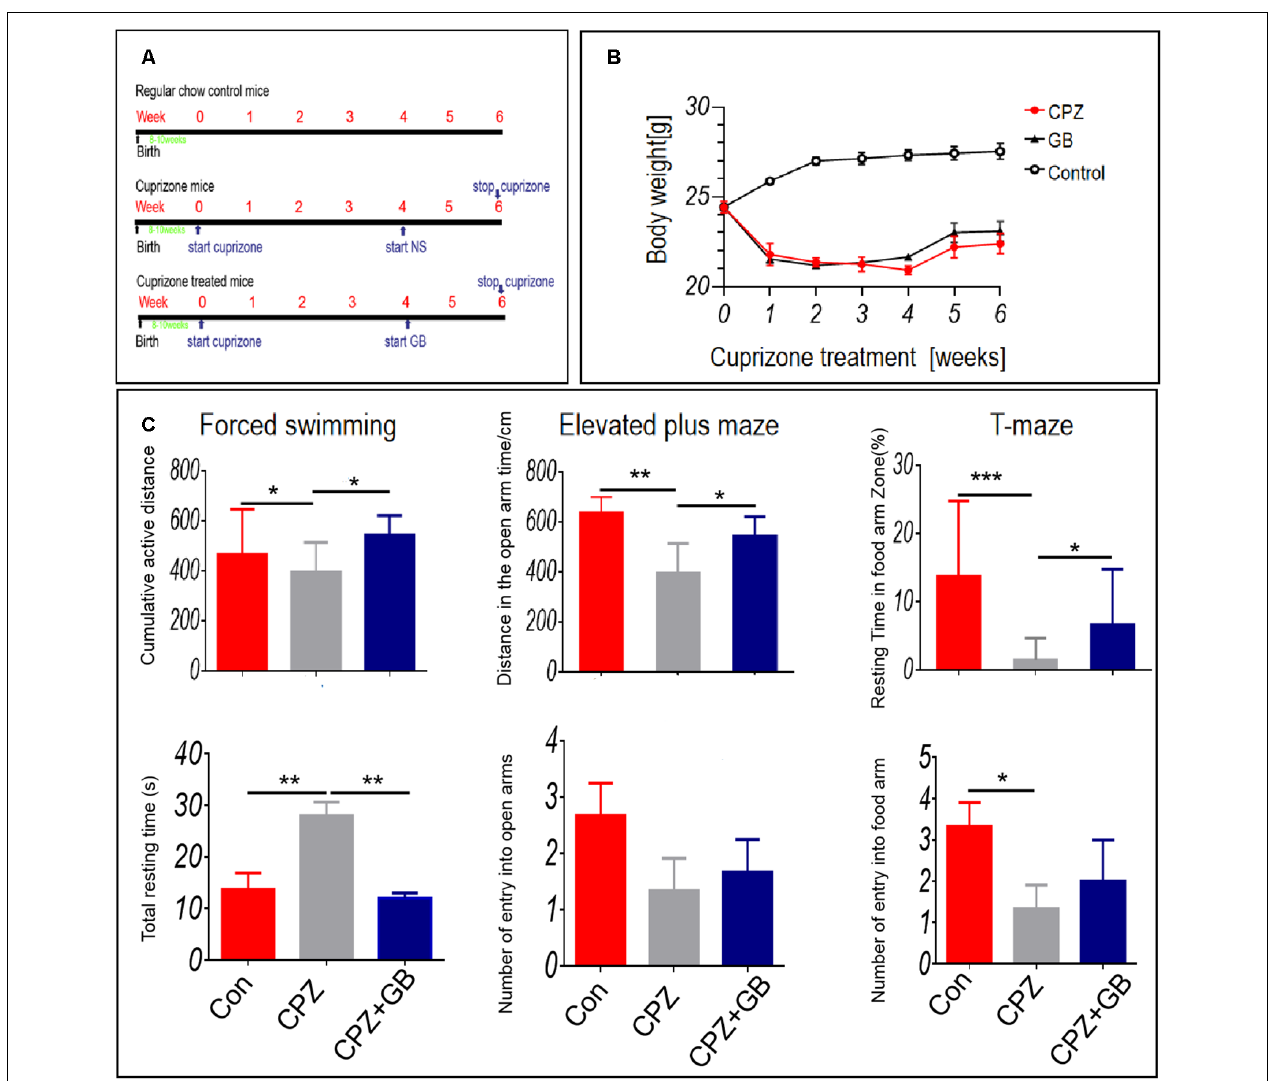
FIGURE 1 | Ginkgolide B (GB) improved behavioral abnormality in cuprizone (CPZ)-induced demyelination. Mice were fed with chow containing 0.2% CPZ for 6 weeks and were intraperitoneally injected with GB for 14 consecutive days from the 4th to 6th week of CPZ feeding. (A) The design scheme of experimental protocol ( n = 8/group), (B) body weight change, (C) anxiety-and depression-like behavior and cognitive function by forced swimming test (FST), elevated plus maze (EPM) and T-maze (TM) tests. Behavioral results were obtained by video camera and quantified by Image-Pro Plus 6.0 software. The results represent